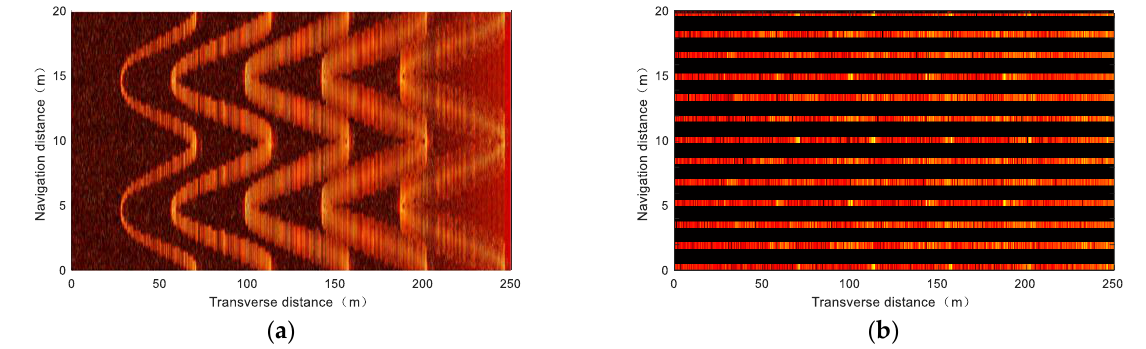
Figure 10. Simulation mapping images of the single–beam side–scan sonar used LFM signal as center frequency 400 kHz, bandwidth 30 kHz, and pulse width 5 ms: ( a ) at 3 knots; ( b ) at 10 knots.